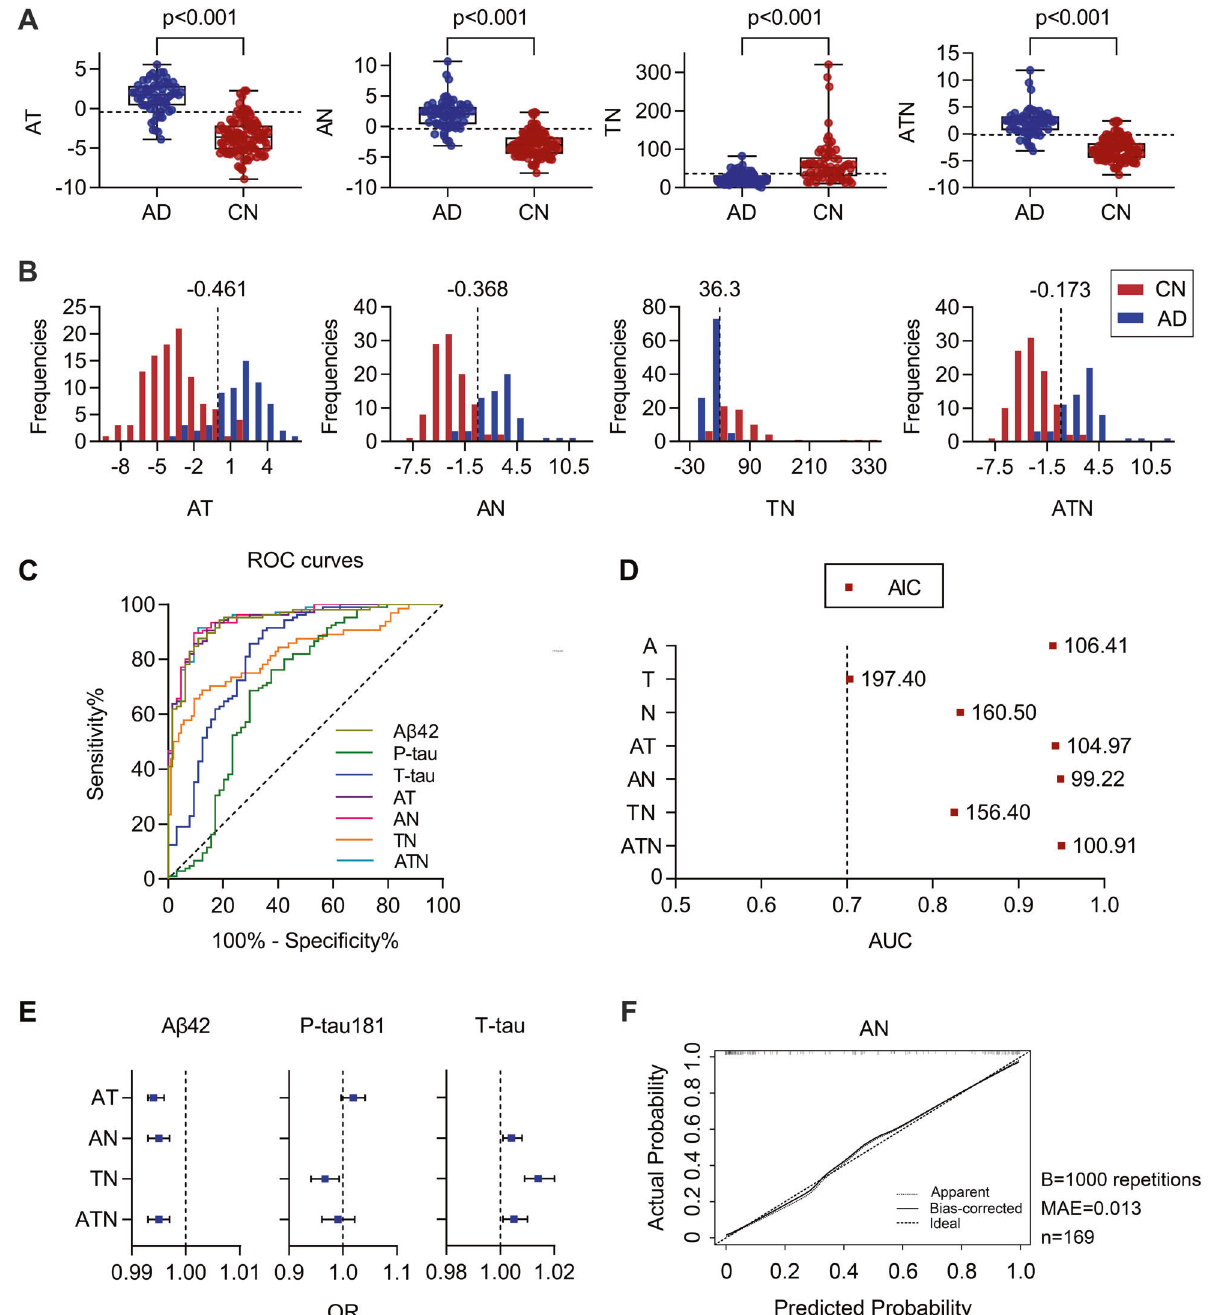
Fig. 3 Combined models of CSF biomarkers. A Comparisons of AT, AN, TN, and ATN model indices between AD ( n = 64) and CN ( n = 105) group. Boxes represent the 25th, 50th, and 75th data percentiles. Whiskers represent the lowest and highest data. The dashed lines indicate the cutoff value for each index. B Frequency distribution of AT, AN, TN, and ATN model indices. The dashed vertical lines indicate the cutoff values for each index. C ROC curves of CSF biomarkers and combined model indices. D AUC (x-axis) and AIC values (numbers in plots) for each biomarker and combined biomarker model. The dashed vertical line shows AUC = 0.7. E The OR values represent the contribution of each biomarker to the combined models. The error bars represent 95% con fi dence intervals. F The bootstrap-validated of CSF AN index. The Y-axis indicates the actual probability of AD and the X-axis indicates the predicted probability of AD. A, A β 42; T, P-tau181; N, T-tau; AD, Alzheimer ’ s disease; CN, cognitively normal; ROC, receiver operating characteristic curve; AUC, area under the curve; AIC, Akaike information criterion; OR, odds ratio; MAE, mean absolute